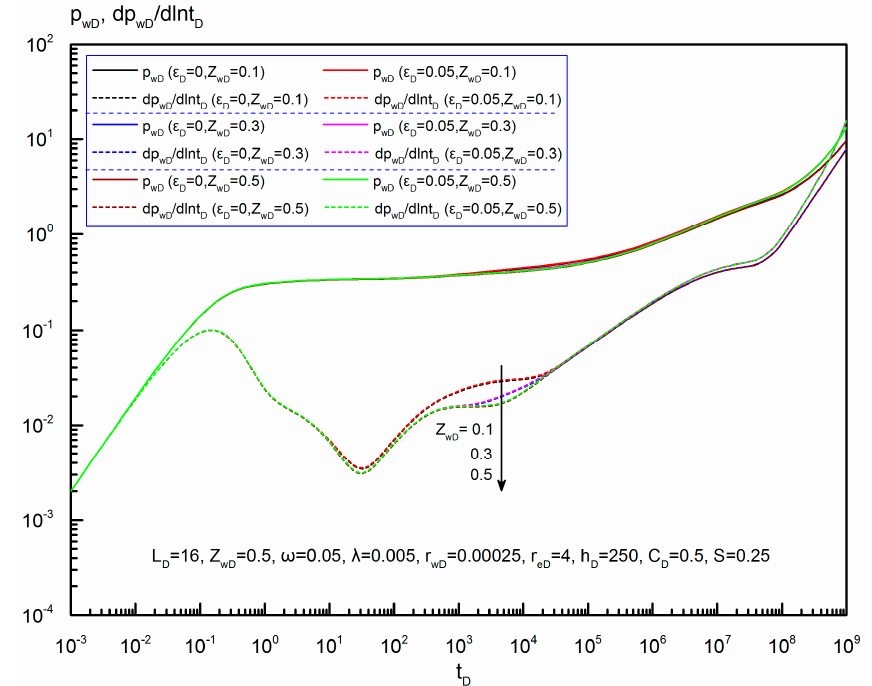
z ) on horizontal well’s transient